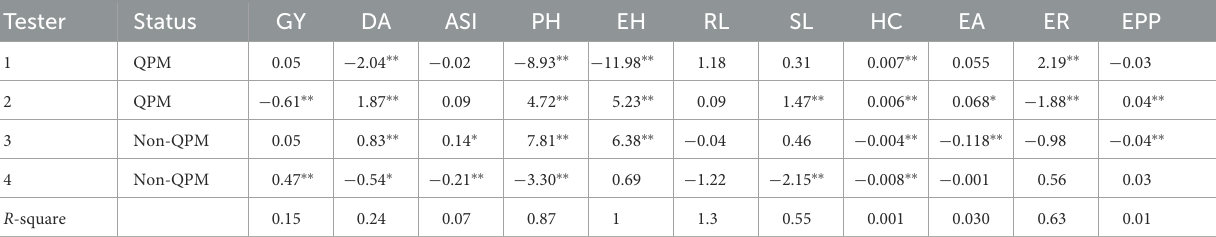
TABLE 4 General combining ability effects of four testers for grain yield and other traits evaluated at 13 locations during the 2018 and 2019 seasons.